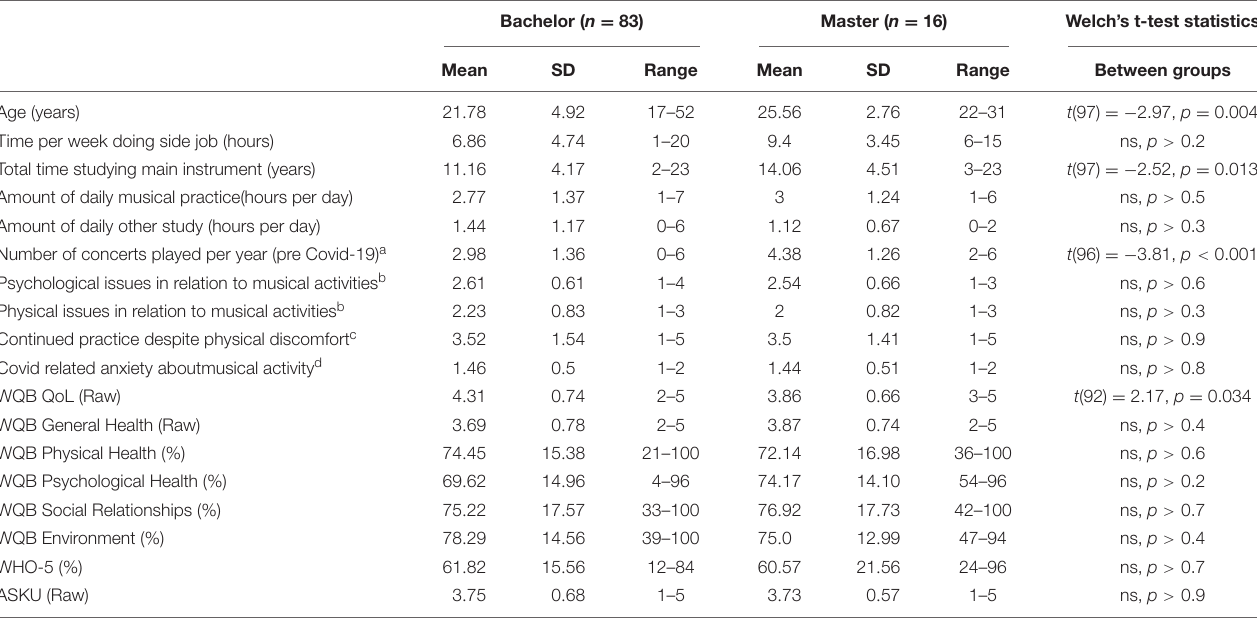
TABLE 1 | Demographic and descriptive information about the sample and between group